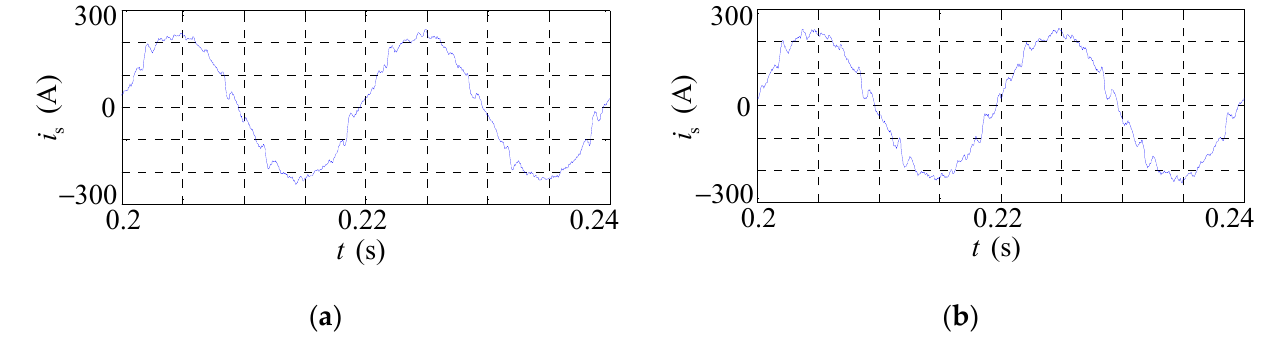
Figure 20. Grid current of hybrid system ( a ) when β = 2%; ( b ) when β = 6%. In the end, corresponding experiments were implemented on the experimental proto- type. The RMS value of the grid line voltage was 380 V. On the load side, the three-phase reactors and SCR rectifiers generated controllable reactive power and harmonics, respec- tively. The grouping method adopted the 4-2-1 rule for the TSC, and the single-phase